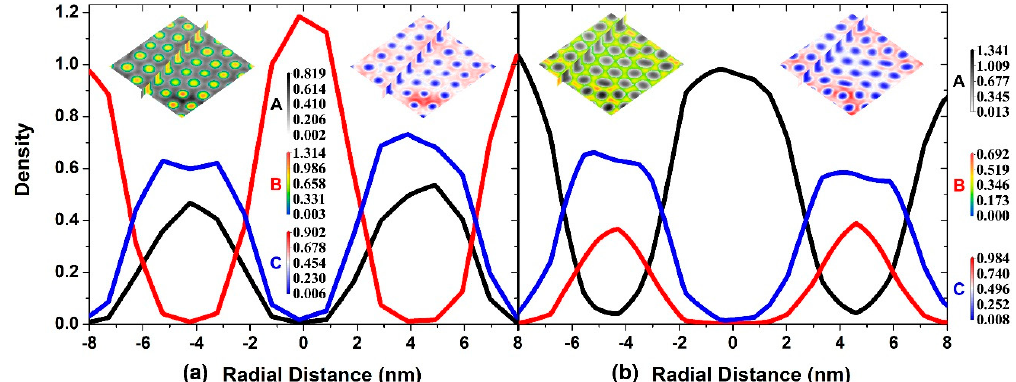
Figure 5. Density profiles of the 3C4 system at the final equilibrium state for ( a ) C[15] interaction and ( b ) C[51] interaction, and the densities of A, B, and C beads are denoted in black, red, and blue lines, respectively. In each subfigure, two density images are inserted. The images represent A–B beads (left) and C beads (right), consisting of two density slices with one density slice along the X–Y plane and the other density slice intersecting the cylindrical axes along one cylindrical array (the latter one is vertical to the former one).